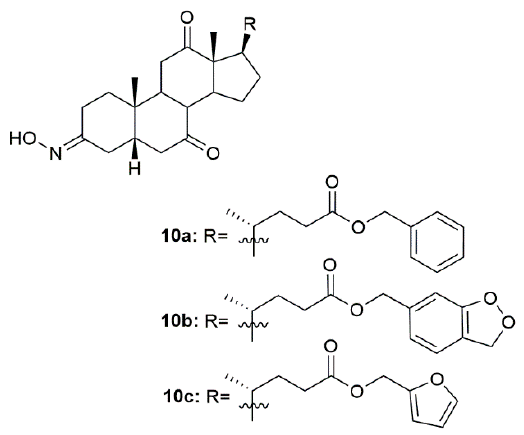
Figure 13. Bile acid oxime derivatives with antiviral